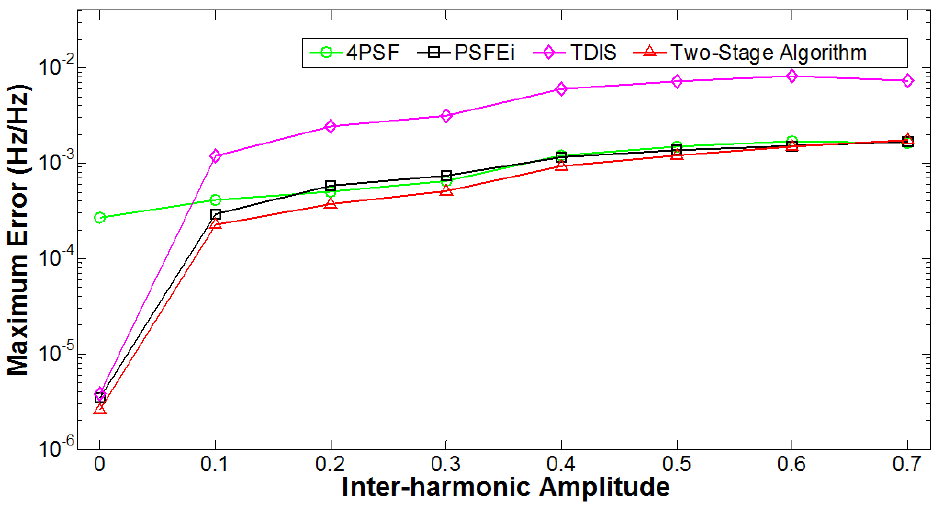
Figure 7. Maximum error of frequency estimation with increasing inter-harmonic